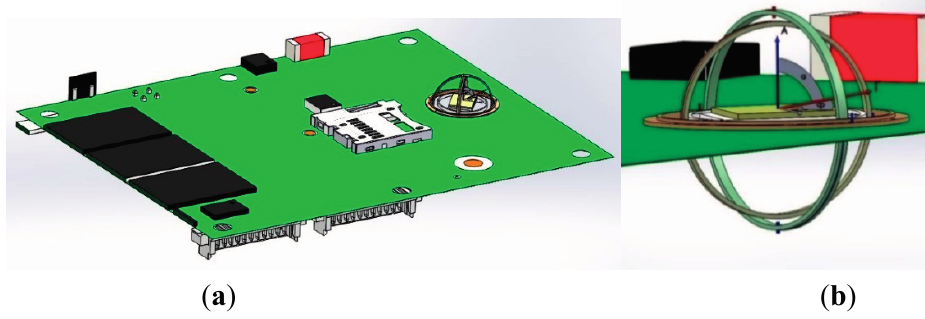
Figure 4. GPS receiver electronic board equipped with the gyroscopic mounting